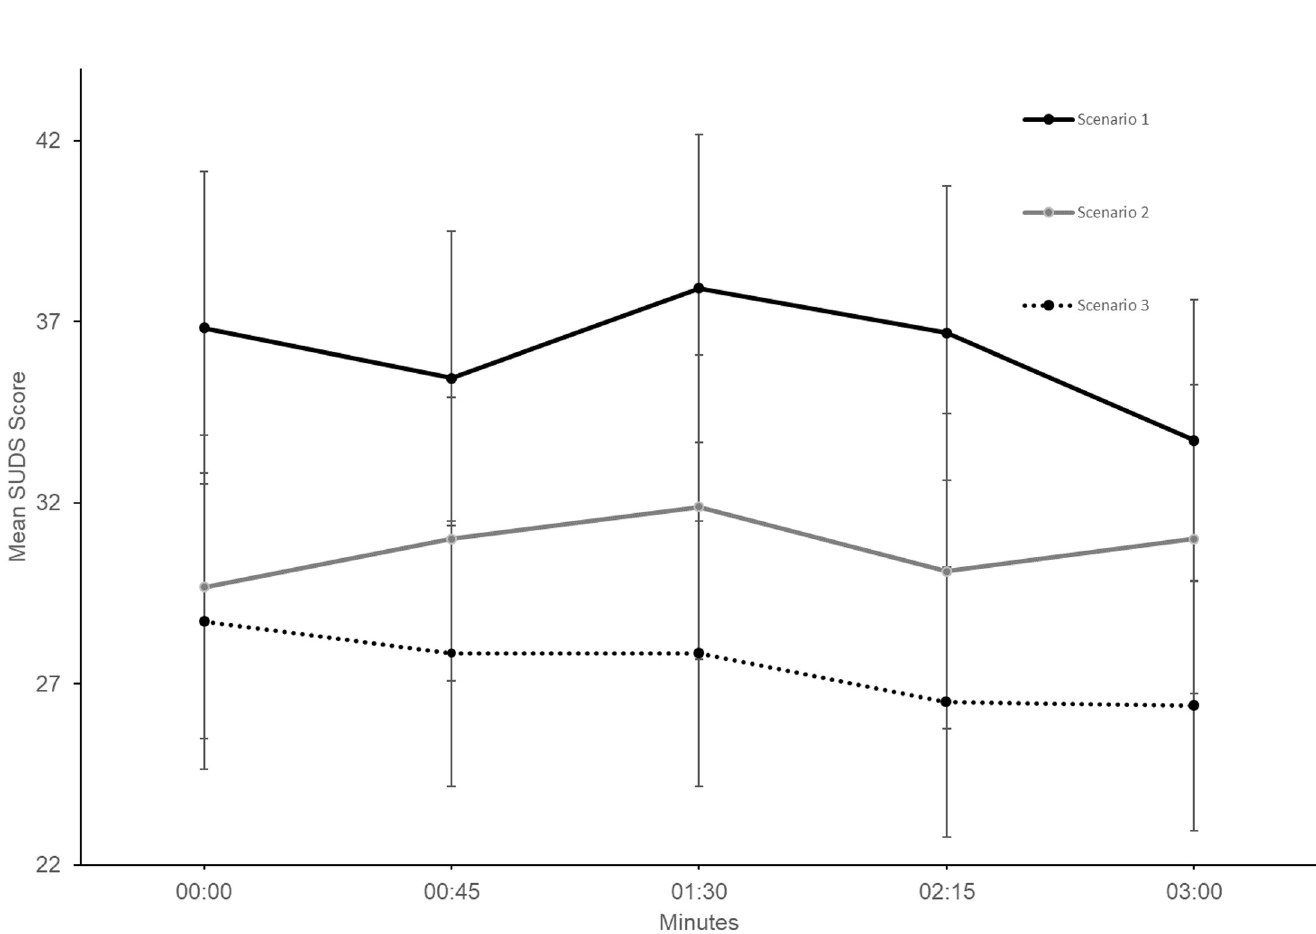
Fig 5. First 3-minutes of within-scenario Subjective Units of Discomfort Scale (SUDS) mean scores for all scenarios (N = 18). Error bars represent standard errors.